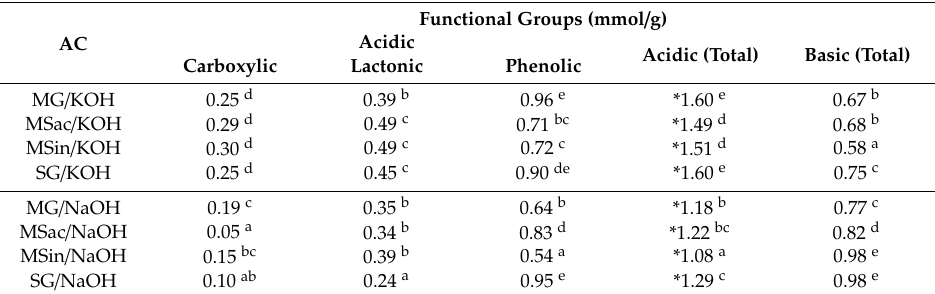
Table 4. Contents of surface oxygen functional groups in activated carbons derived from miscanthus and switchgrass biomass. Significant di ff erences between activated carbons (ACs) are marked by letter indexes, separately for each group (in columns). Significant di ff erences between concentrations of total acidic vs. basic groups for a given AC are indicated by asterisk (in respective rows).